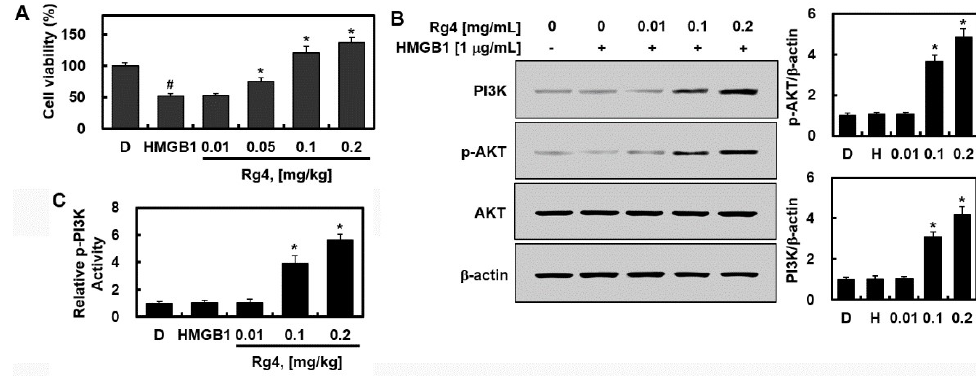
Figure 4. Increased cell survival through induction of PI3K/AKT signaling by Rg4 in HMGB1-mediated sepsis in vitro. HUVECs were activated with HMGB1 (1 μg/mL) for 6 h and then treated with various concentrations of Rg4 for another 6 h. ( A ) The MTT assay was performed to assess cell viability. Cell lysates were subjected to Western blot analysis to estimate protein levels of PI3K, p-AKT, and total AKT ( B ) or to ELISA for phosphor-PI3K ( C ). Representative Western blots (left) and relative densitometric quantification (right) of each gene. All values are presented as the mean ± SD of three separate experiments. D = 0.5%, DMSO was the vehicle control and H = HMGB1. # p < 0.01 vs. DMSO or * p < 0.01 vs. HMGB1 group.